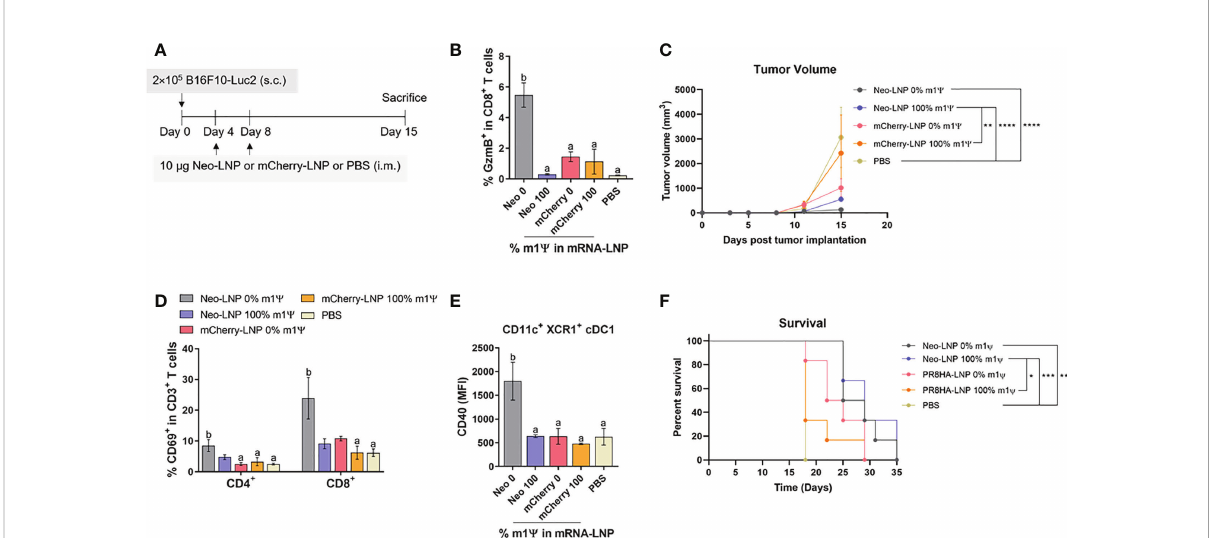
FIGURE 8 Neoantigens (Pbk-Actn4) encoding mRNA-LNP inhibits tumor growth in vivo and prolongs survival. (A) Schematic representation of the immunization regimen to test the anti-tumor ef fi cacy of neoantigen encoding mRNA-LNP. See methods for details. (B) The frequency of GzmB- producing splenic CD8 + T cells on CD3 + CD8 + T cell subsets was determined by fl ow cytometry. (C) Tumor volume was measured ( n = 10) (D) The frequencies of CD69 + T cells among tumor in fi ltrated CD4 + and CD8 + T cells are shown. (E) The MFI of costimulatory molecule CD40 on tumor- in fi ltrating cDC1 is shown ( n = 4). (F) The percentage of survival was followed until day 35 ( n = 6). GzmB, granzyme; cDC1, conventional type 1 dendritic cell. (B) The results are presented as the mean ± SEM. Statistical signi fi cance: (*) p < 0.05, (**) p < 0.01, (***) p < 0.001 and (****) p < 0.0001 by two-way ANOVA with Bonferroni multiple comparisons test. Survival curves were compared using log-rank (Mantel – Cox)